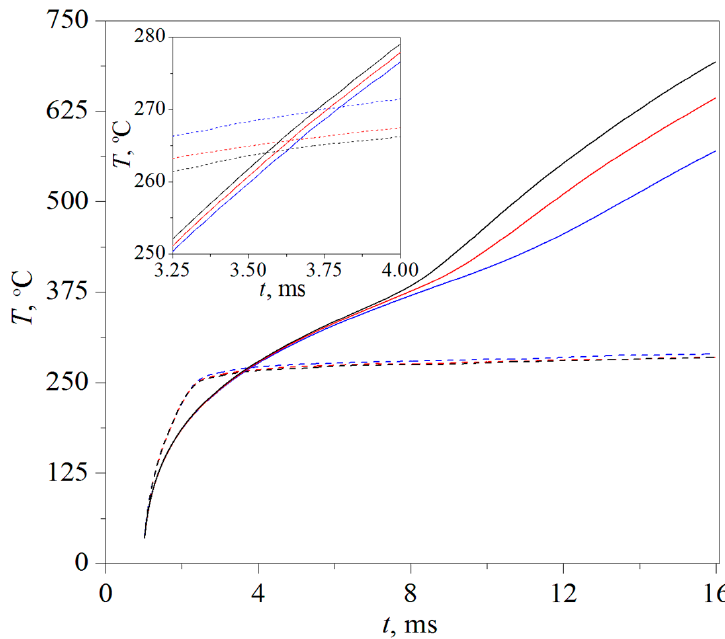
Figure 8. Comparison of the results for a mixture containing 30 wt.% PPG-425 (dotted lines) and water